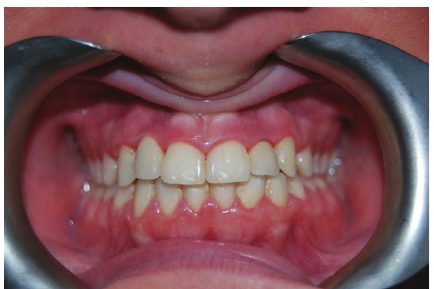
Figure 15: Implant prosthesization.